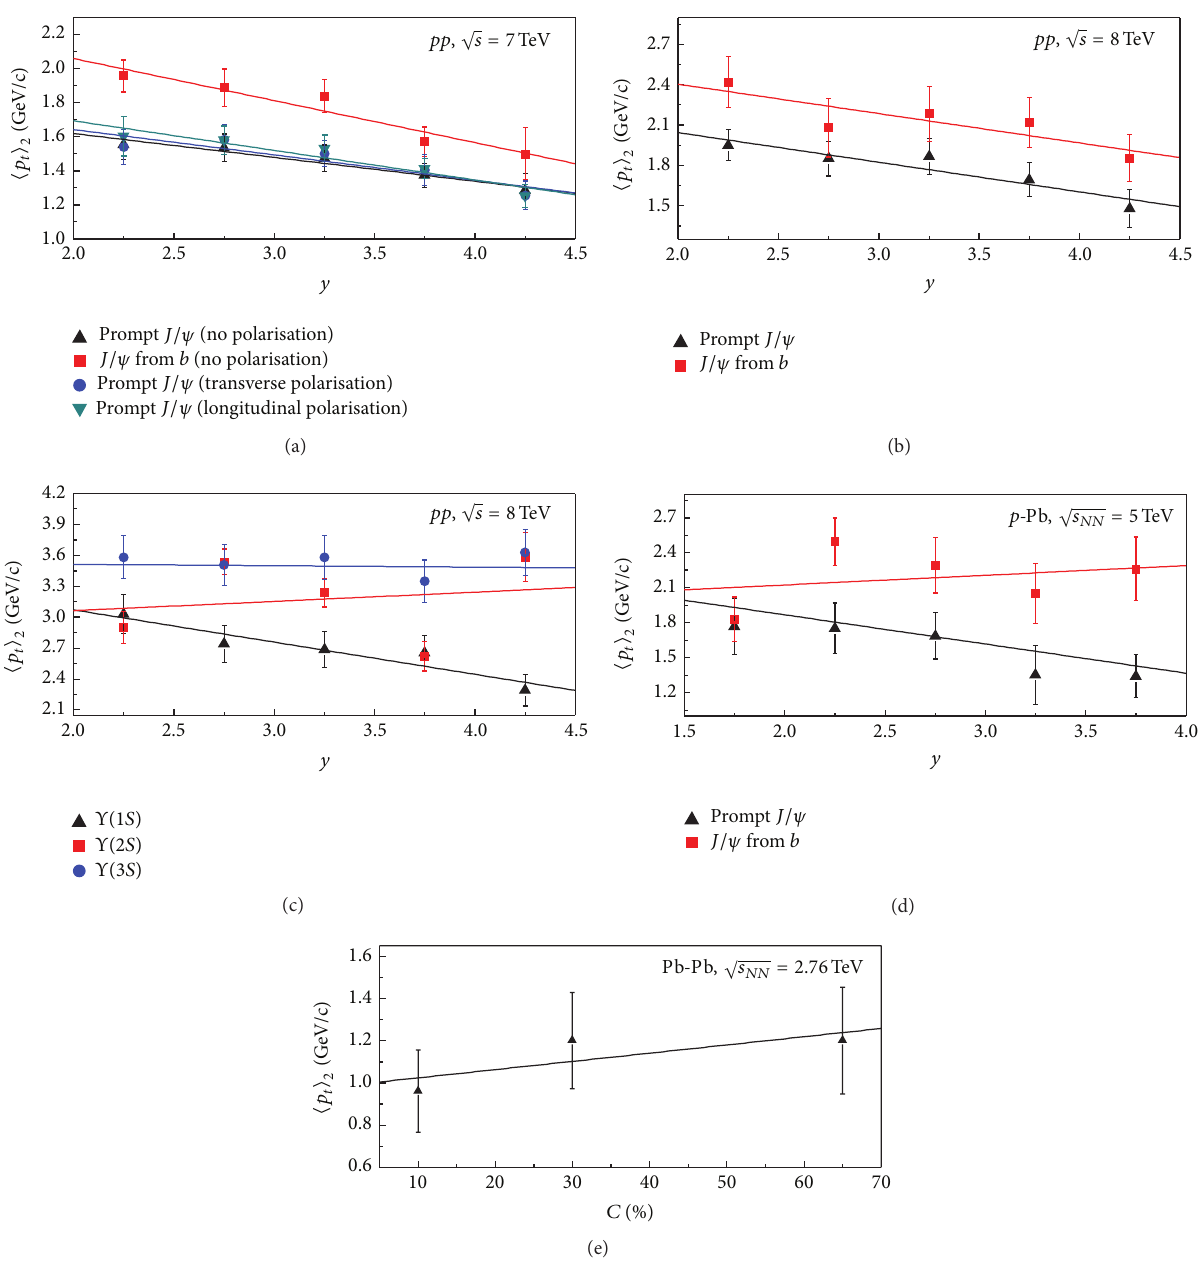
Figure 8: The same as Figure 6 but showing the results for ⟨𝑝 𝑡 ⟩ 2